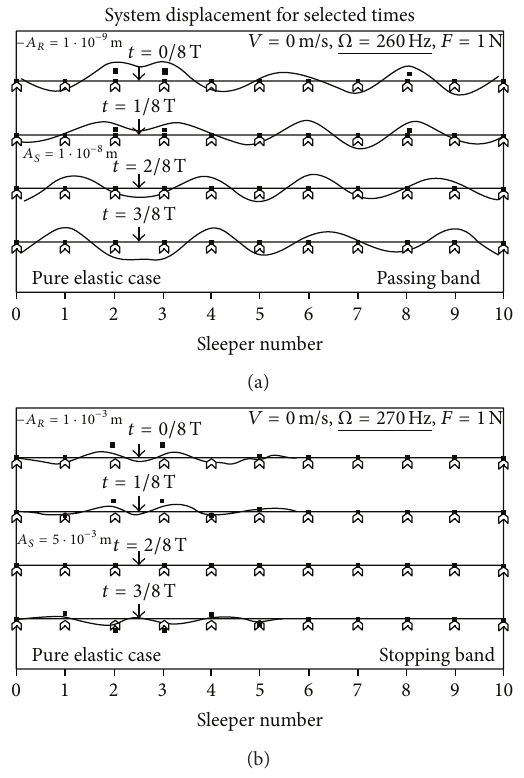
Figure 2: Waves in railway track as periodic structure-passing band and stopping